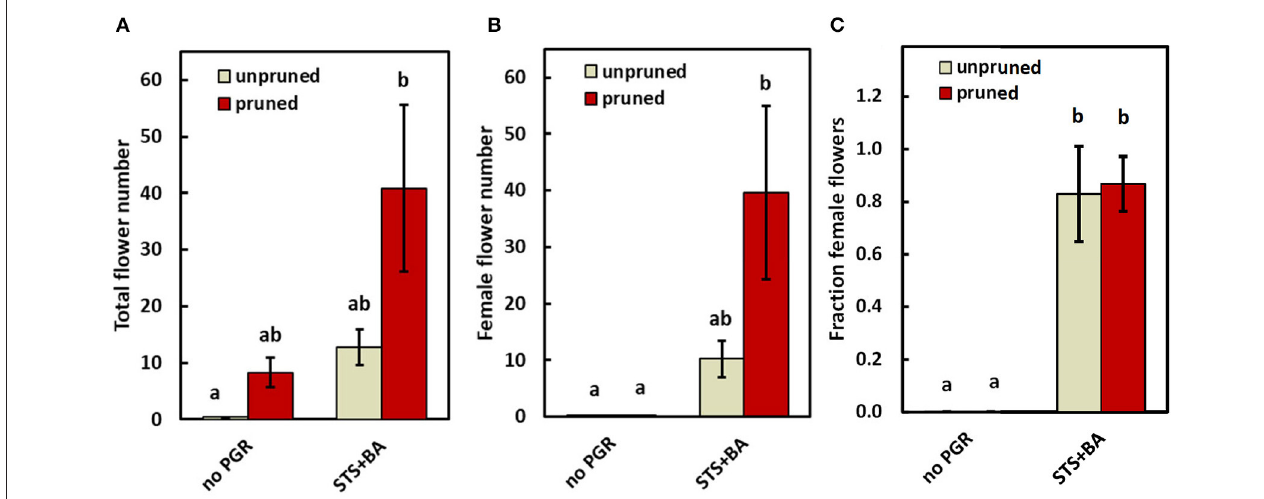
FIGURE 4 | The effect of PGRs (combined STS + BA) and pruning on flower development under greenhouse conditions. (A) Total flowers, (B) female flowers, and (C) proportion of female flowers. Means ± SEM of five biological replicates are shown for the genotype TMS-I980002. Treatments with different lowercase letters are significantly ( P ≤ 0.05) different using Tukey’s HSD test. Comparisons and letter assignments were based on estimated marginal means (EMMs, least-squares means), as appropriate for statistical comparisons; arithmetic means and SEMs are plotted.